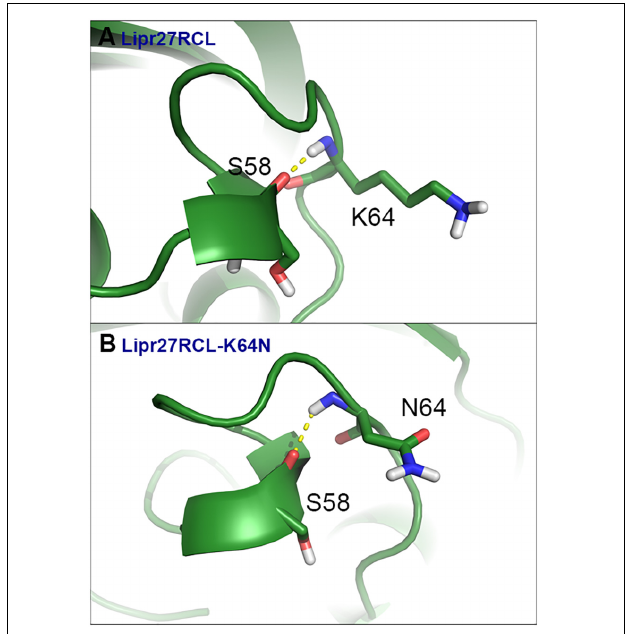
FIGURE 6 | MD simulations Of Lipr27RCL (A) and Lipr27RCL-K64N (B) conducted at 60 ◦ C.